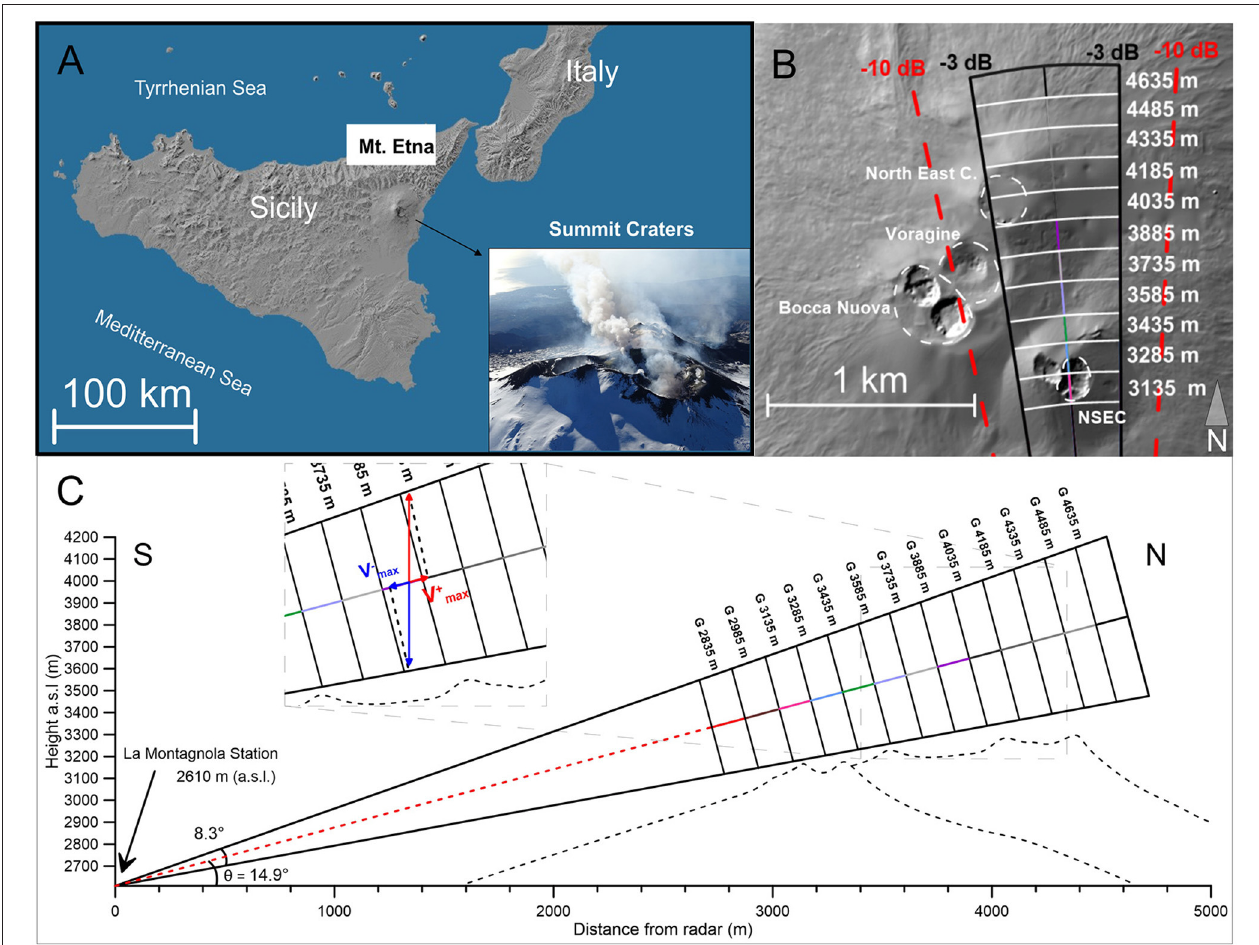
FIGURE 1 | (A) Mount Etna location and photograph of the summit crater (courtesy of Boris Behncke). Geometry of radar beam above Etna’s summit craters: probed volumes are drawn at − 3 dB, i.e., at half the power in the beam axis, and dashed lines indicates beam limit at − 10 dB; (B) top view (after Oct. 10 2012); (C) S-N cross-section view (aperture angle of 8.3 ◦ in elevation at − 3 dB): before December 16 2013, 11 range gates (3,135–4,635m) were monitored and 13 gates (2,685–4,485m) after this date. Inset: for range gates above the emission source, the positive ( v + max ) and negative ( v − max ) radial velocities measured along-beam mainly stem from ascending and falling tephra,